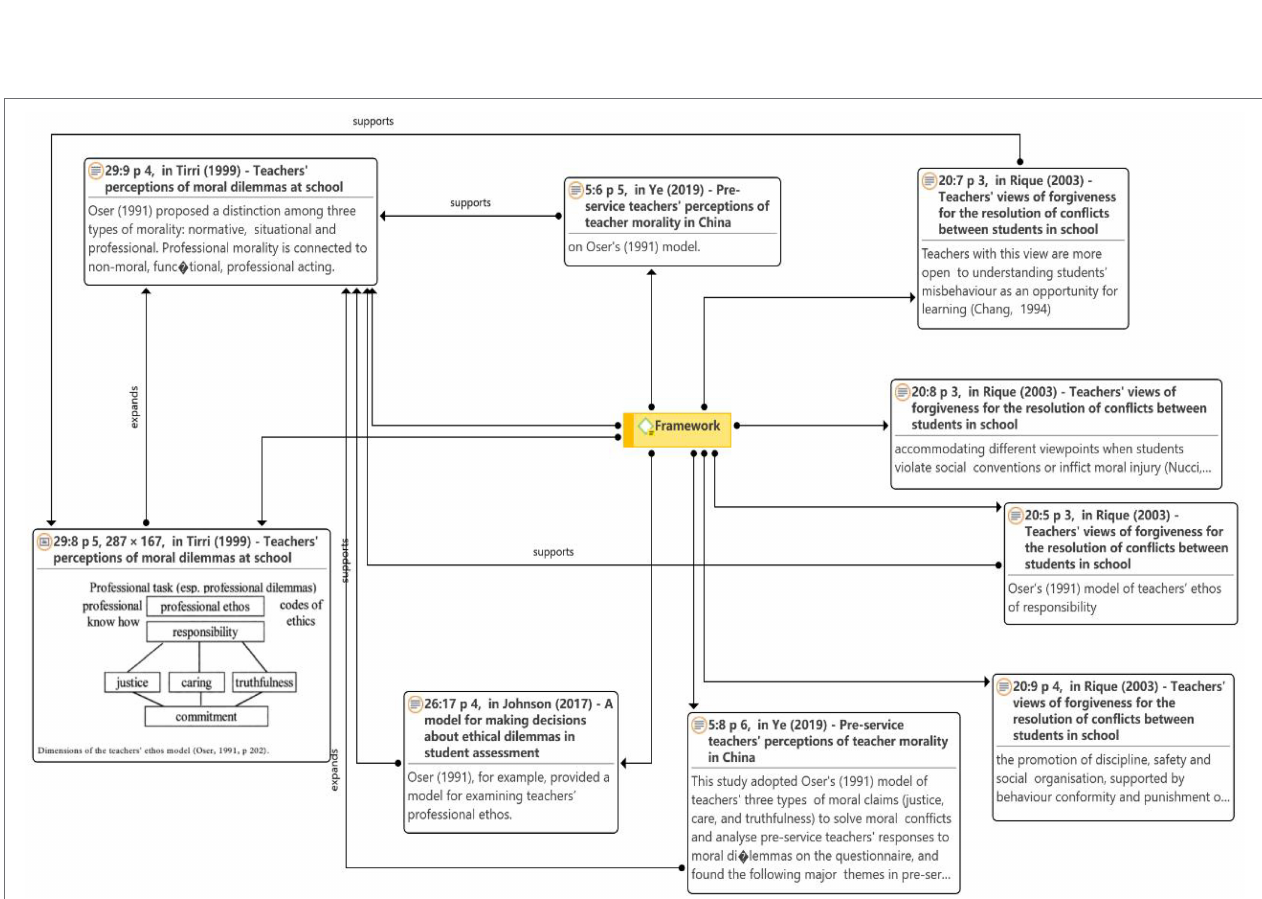
FIGURE 5 | Network on the model of teachers’ perceptions of moral and national education theme.